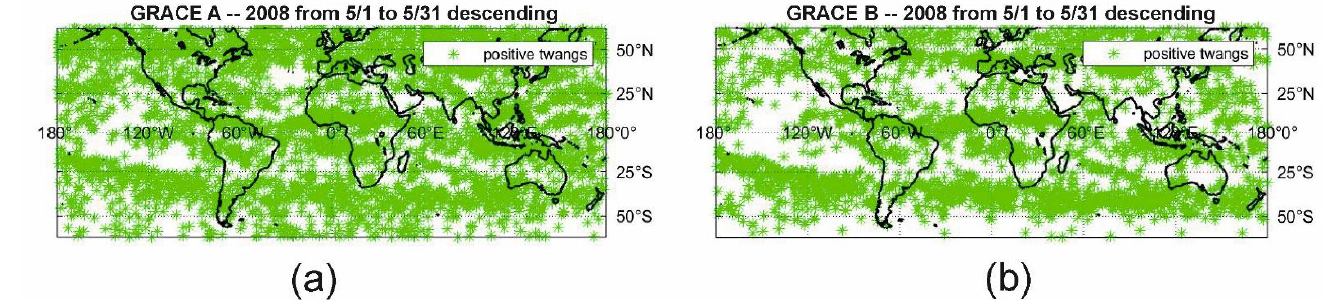
Figure 10. Comparison of the geographical structure of twangs between GRACE A ( a ) and GRACE B ( b